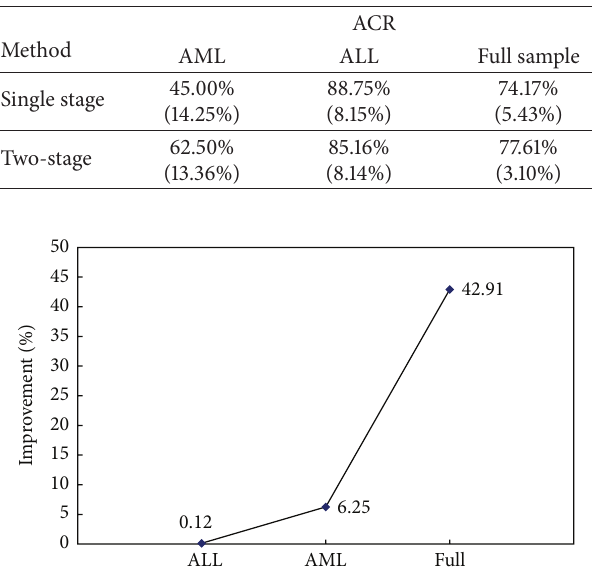
Figure 1: Improvement of the proposed approach in comparison with the single stage